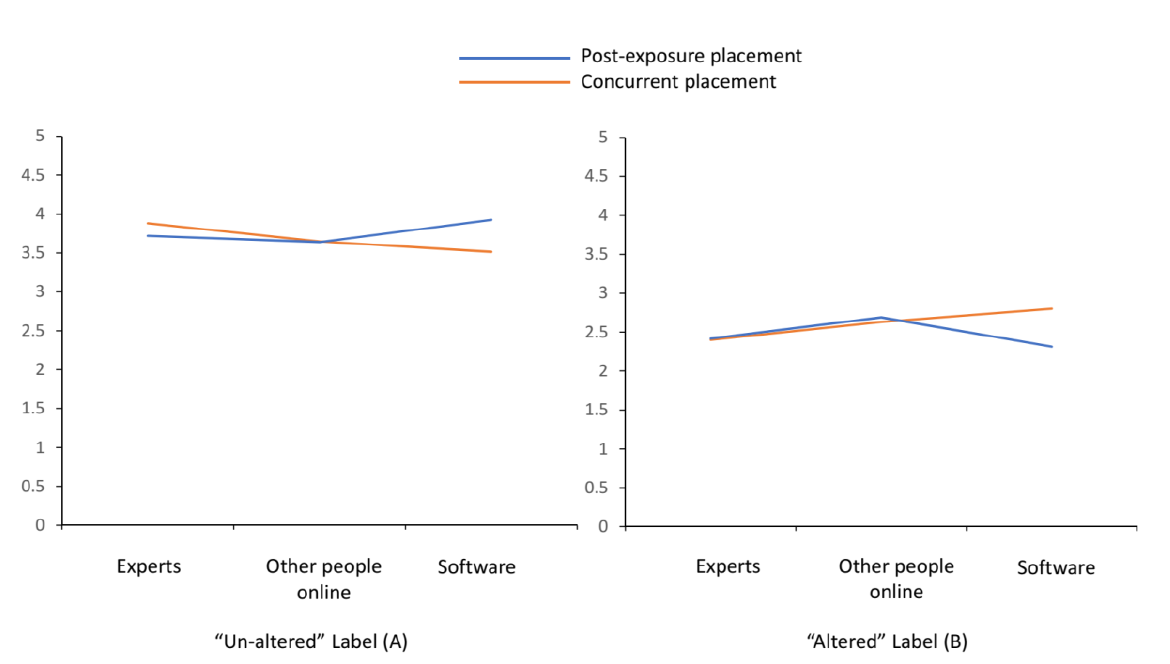
Figure 7. Interactions between forensic label placement and source of forensic label. Higher numbers represent greater perceived image credibility. Panel (A) shows the participants exposed to the “Un - altered” label, and Panel (B) shows those exposed to the “Altered”